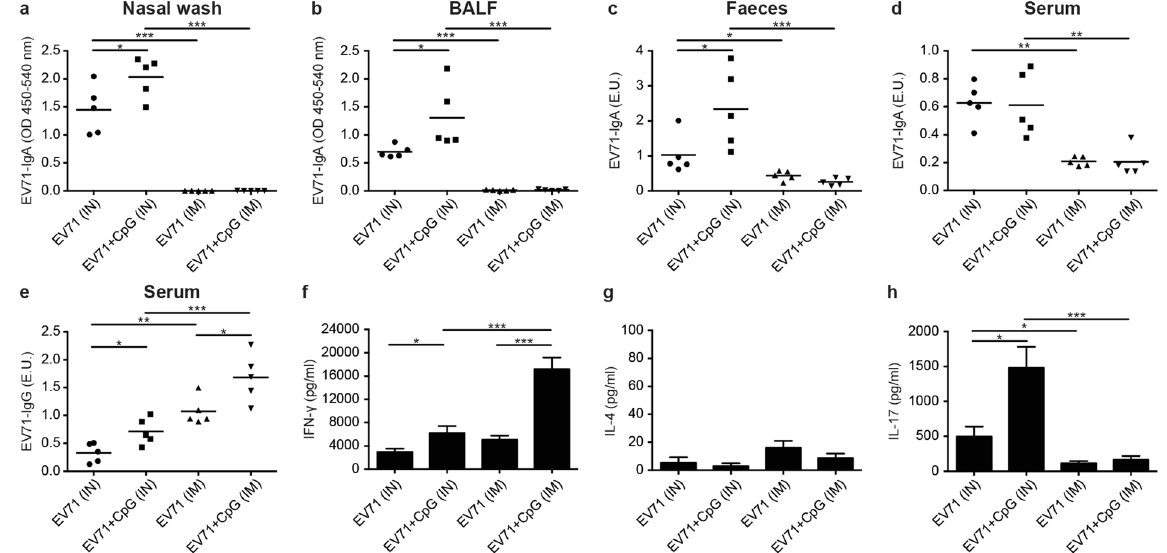
Figure 7. Comparison of the effects of the intranasal (IN) and intramuscular (IM) immunisation routes on EV71-specific antibody titres and cytokine production. Mice were IN or IM immunised with PBS or formalin- inactivated EV71 (5 μ g/dose) alone or adjuvanted with CpG (20 μ g/dose) three times at 3-week intervals. ELISA was used to measure EV71-specific IgA in the nasal wash ( a ), BALF ( b ), faeces ( c ), and serum ( d ) and EV71- specific IgG in the serum ( e ) of mice at 2 weeks after the third immunisation. Splenocytes from immunised mice were harvested and cultured for 2 days in medium containing 10 μ g/mL heat-inactivated EV71, after which culture supernatants were analysed for IFN- γ ( f ), IL-4 ( g ), and IL-17 ( h ) using ELISA. One representative study of two with similar results is shown. Values shown are means ± SEMs of five mice in each experimental group; * p < 0.05, ** p < 0.01, *** p < 0.001. BALF: bronchoalveolar lavage